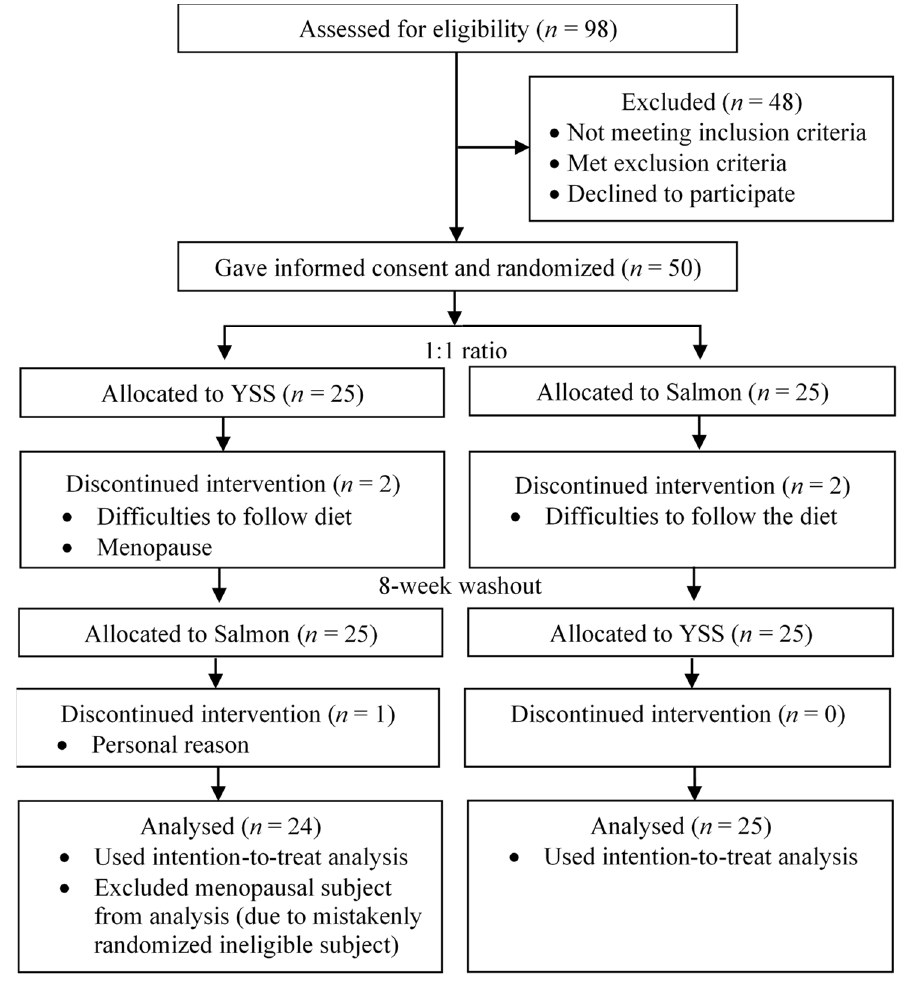
Figure 1. CONSORT subject flow diagram over the 24-week study period. Table 3. Socio-demographic characteristics of subjects ( n = 49). Table 4. Fatty acid composition of